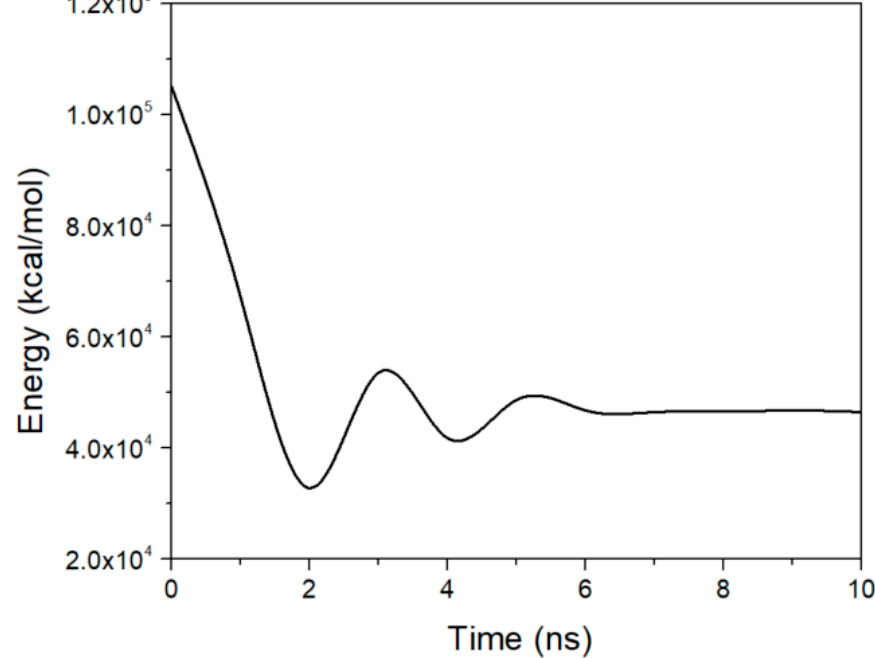
Figure 3. Equilibrium curve for energy of the graphene-PAO nanofluids.